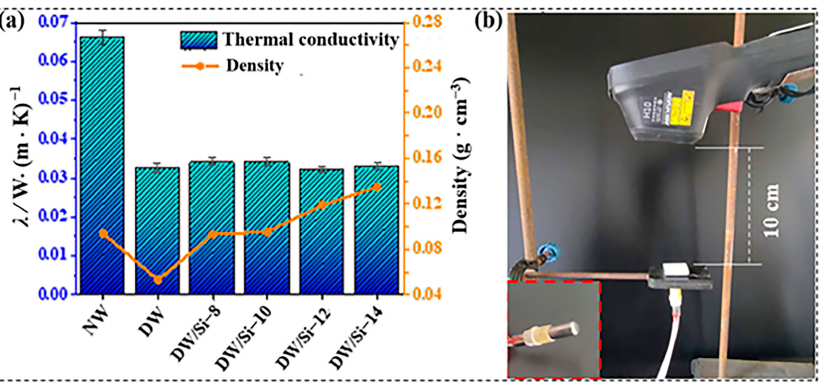
Figure 6. ( a ) Densities and thermal conductivity of the samples and ( b ) the experimental setup; inset is the point heat source.